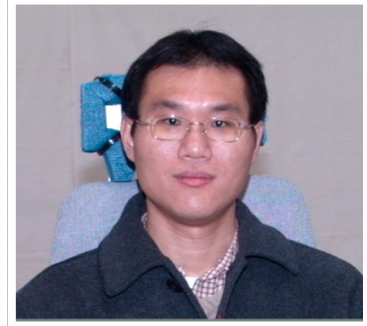
Figure 12. Multi-PIE database example photo (8)-135.